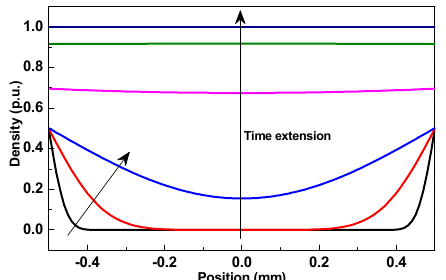
Figure 7. Normalized time and position dependent nanoparticles’ density within NP.